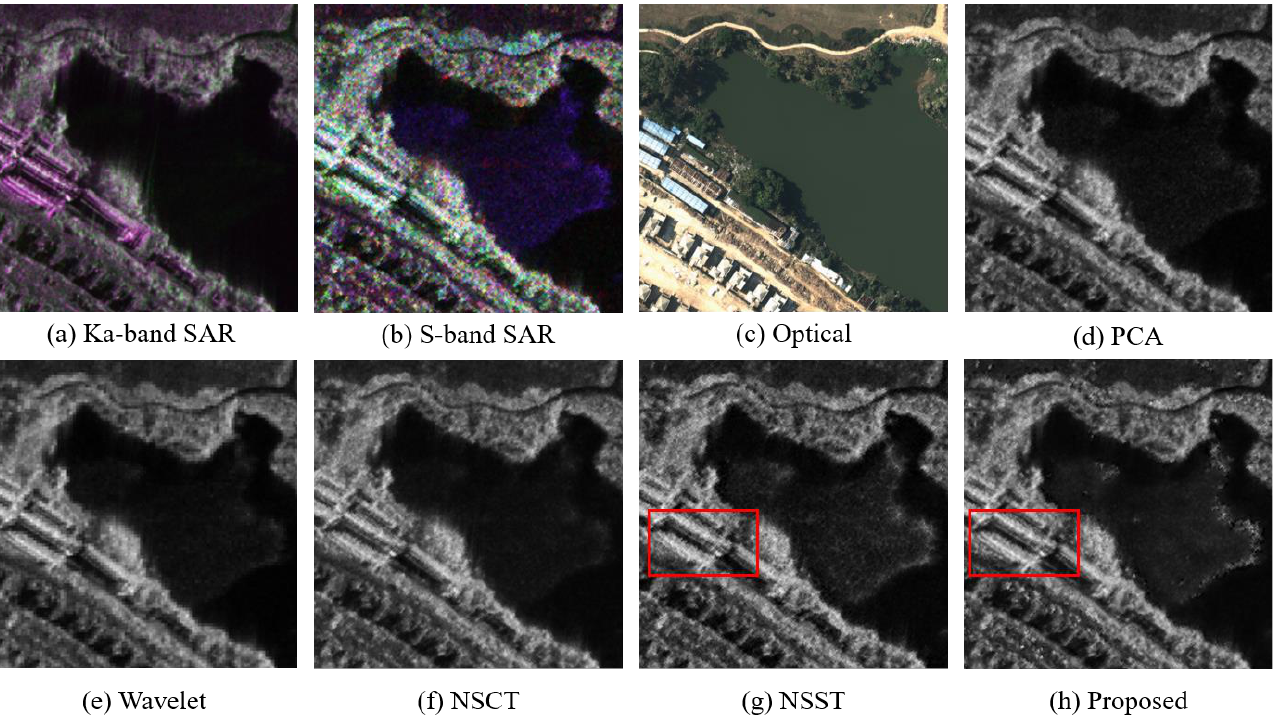
Figure 7. Representative region in scene 2 and its fusion results: ( a ) Ka-band SAR image; ( b ) S-band SAR image; ( c ) optical image; ( d ) PCA fusion; ( e ) wavelet fusion; ( f ) NSCT fusion; ( g ) NSST fusion; and ( h ) proposed method fusion.